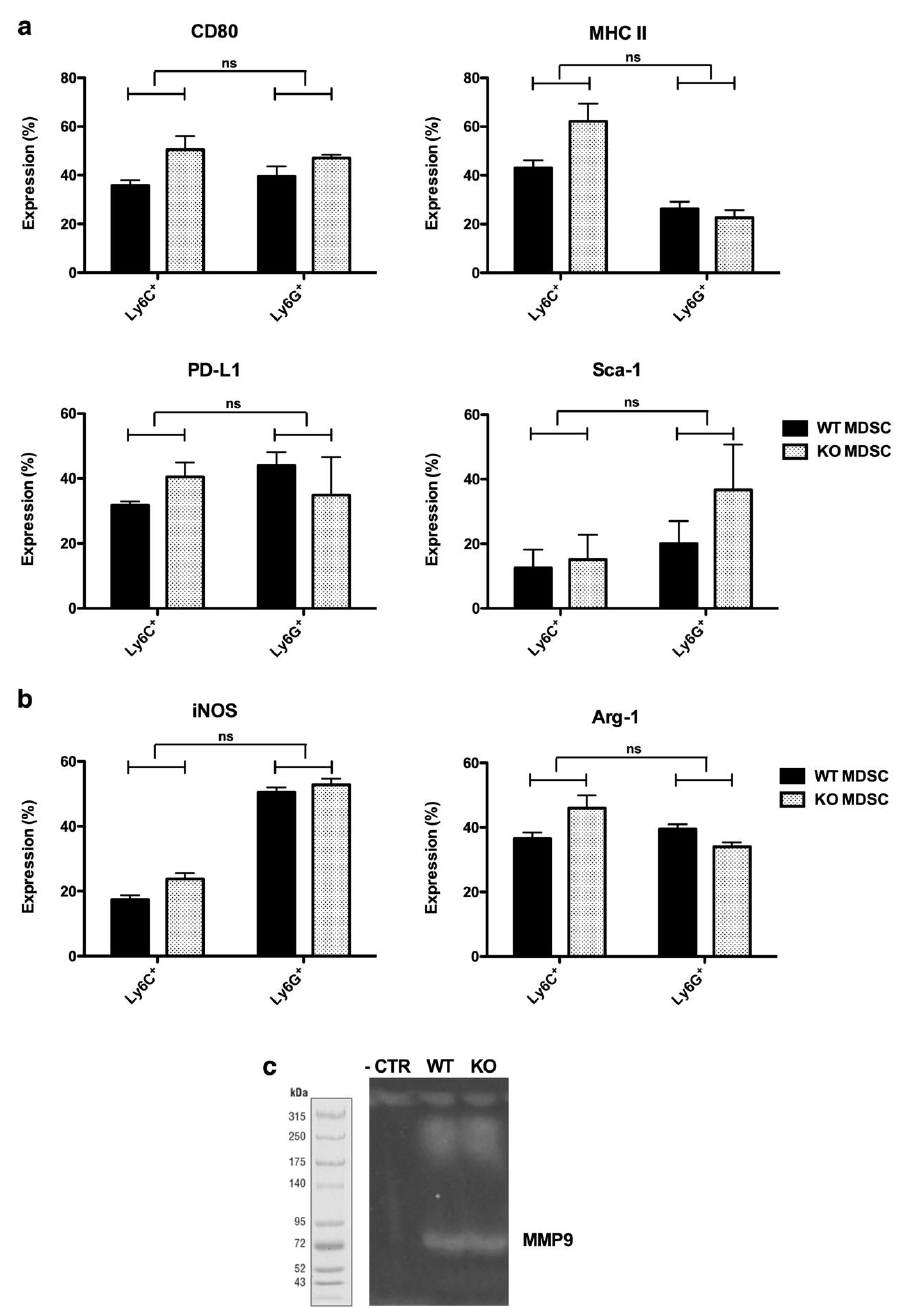
Figure 3. In vitro WT and KO MDSCs show similar properties. ( a ) Summarizing graphs showing the expression of di ff erent surface markers (CD80, MHC II, programmed death-ligand 1 (PD-L1), and Sca-1) on WT and KO MDSCs, gated by CD11b + . Expression showed in M-MDSCs (Ly6C + ) and PMN-MDSCs (Ly6G + ) separately. ( b ) Summarizing graphs showing the expression of functional markers (inducible nitric oxide synthase (iNOS) on the left and arginase-1 (Arg-1) on the right) on WT and KO MDSCs. The mean +/ -SEM of at least three experiments is shown in all graphs. A student’s t-test was used to calculate the statistical significance. The number of asterisks in the figures indicates the level of statistical significance as follows: ns, > 0.05 and *, p > 0.05. ( c ) Representative image of gelatin zymography assay showing MMP9 activity in WT and KO